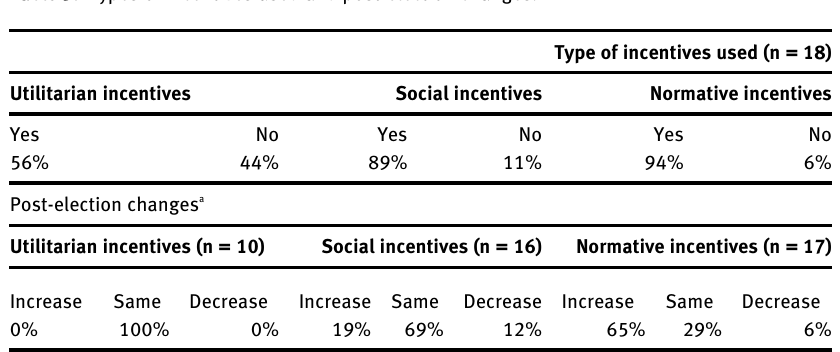
Table  : Types of incentives used and post-election